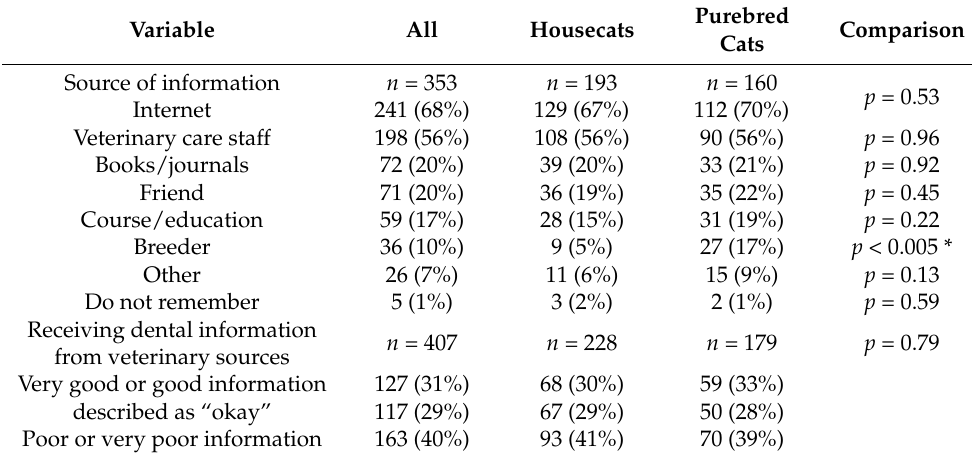
Table 3. Description of sources of information regarding dental health, for cat owners and by breed type owned (purebred versus housecat). Comparisons between purebred and housecat owners were performed using Chi-squared test except where any cells were n < 15 where Fisher’s exact test was used. The p -value for statistical significance was adjusted for the number of tests ( n = 8) using Bonferroni correction: 0.05/8 = 0.00625, and * indicates statistical significance. For the variable Receiving dental information from veterinary sources, the statistical test applies to the overall variable, not individual comparisons between